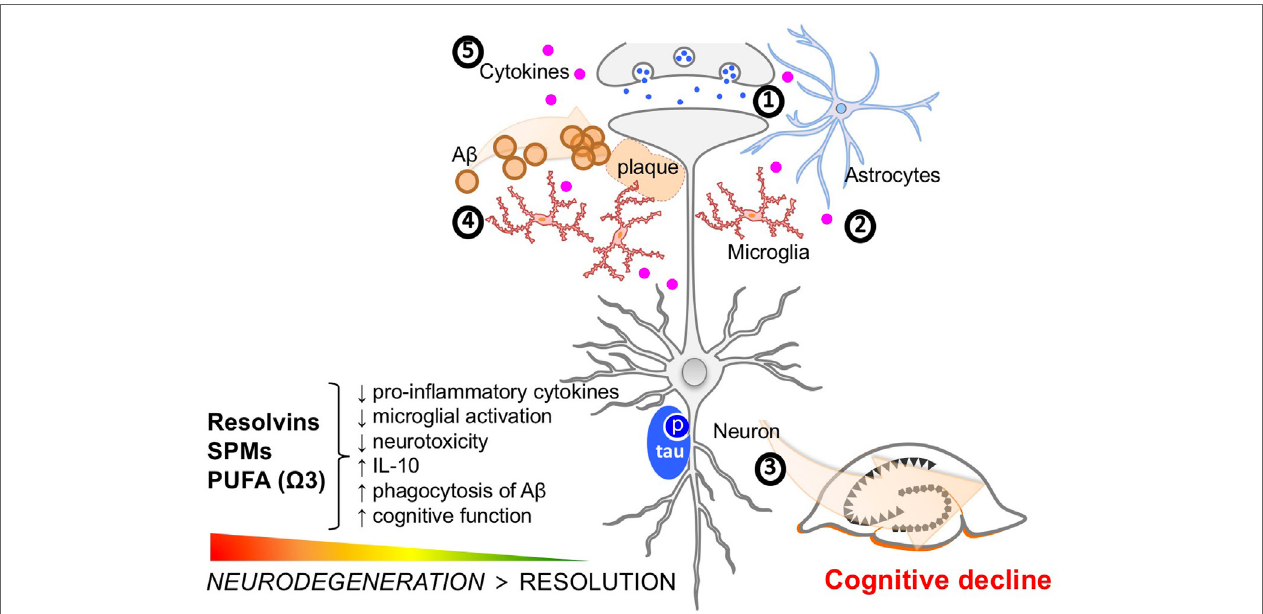
FigURe 2 | Molecular features of Alzheimer’s disease (AD) pathophysiology and key targets of resolution agonists in neurodegeneration. Clockwise from 12 o’clock (1) neurotoxicity, including dysregulated glutamate and calcium signaling, and neurotransmission imbalance contribute to synaptic dysfunction and neuronal loss; (2) glia activation, including microglia and astrocytes, interfere with immunological processes in the brain further promoting non-resolving inflammation and neurodegeneration; (3) tau phosphorylation and neurofibrillary tangle formation; (4) A β plaque formation are key hallmarks of the AD brain. Specialized pro-resolving mediators and strategies aimed at boosting resolution such as using omega-3 polyunsaturated fatty acid exert differential effects on these targets and provide anti-inflammatory and pro-cognitive effects in neuroinflammation/degeneration; and (5) The accumulation of A β may lead to the microglial accumulation and activation resulting in increases in pro-inflammatory cytokines such as interleukin-1 beta, interleukin-6, and tumor necrosis factor-alpha. These cytokine increases in the brain can subsequently lead to tau hyperphosphorylation and a pathological cycle of increased A β deposition and persistent microglial activation, ultimately resulting in chronic neuroinflammation and